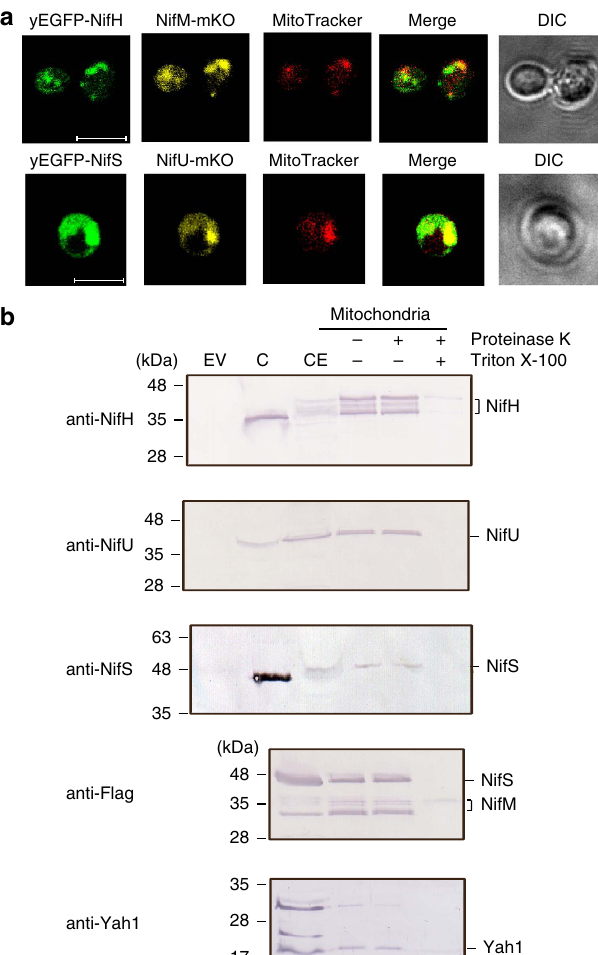
Figure 1 | Mitochondrial targeting of Nif proteins. ( a ) Confocal microscopy images of S. cerevisiae strains carrying synthetic sod2 - yEGFP - nifH and sod2 - nifM - mKO (strain GF5) or sod2 - yEGFP - nifS and sod2 - mKO-nifU genes (strain GF7), which expression was induced by galactose in the growth medium. The mitochondria of galactose-induced cells were localized with MitoTracker Deep Red. Scale bar, 5 m m. ( b ) Immunoblot analysis of isolated mitochondria developed with antibodies against NifH, NifU, NifS, Yah1 or FLAG (to detect NifS and NifM at the same time). EV represents cell-free extracts from recombinant yeast carrying pESC-His and pESC-Ura plasmids. CE represents cell-free extracts from recombinant yeast carrying NifH, NifM, NifU and NifS cloned into pESC-His and pESC-Ura plasmids (strain GF8). C represents control lanes with purified Nif proteins from A. vinelandii . Isolated mitochondria were treated with proteinase K either in the absence of detergent (for the removal of outer membrane proteins) or in the presence of Triton X-100 (to permea- bilize the